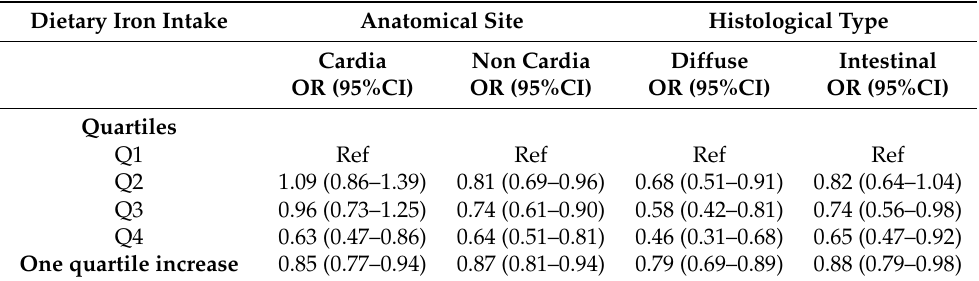
Table 3. Adjusted odds ratios and 95% confidence intervals of the association of total dietary iron intake by quartile, anatomical site and histological type of gastric cancer.